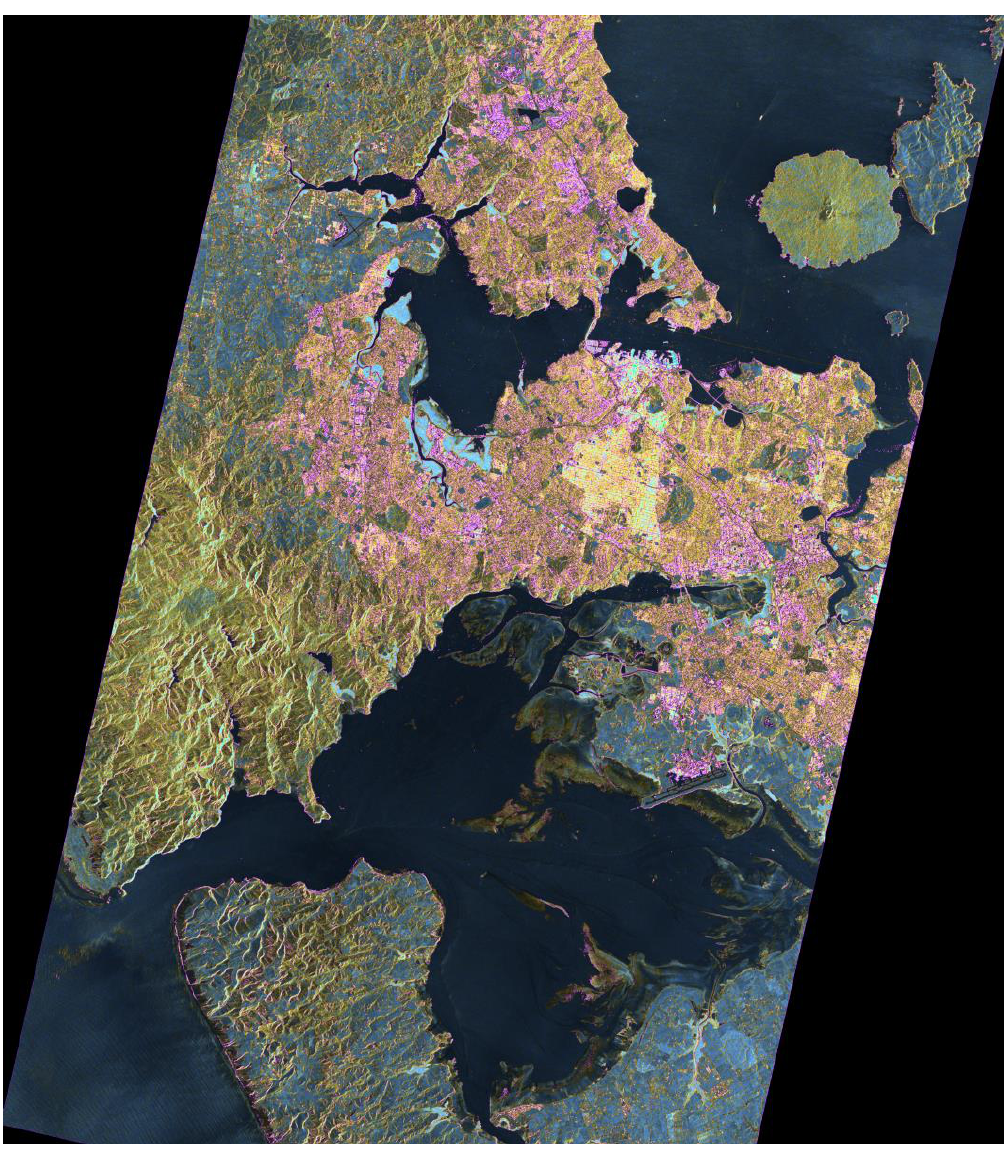
Figure 2. Example for the additional quicklook files with a color representation of the Synthetic Aperture Radar (SAR) image pixel statistics that supplement each TerraSAR-X level 1 product since April 2009: Single polarization Stripmap GEC product of Auckland, New Zeeland acquired in June 2008. These quicklooks are adaptively “tuned” by the TerraSAR-X Multi-mode SAR Processor (TMSP) to support visual interpretation of the image content and not meant for tasks like scientific land cover classification.